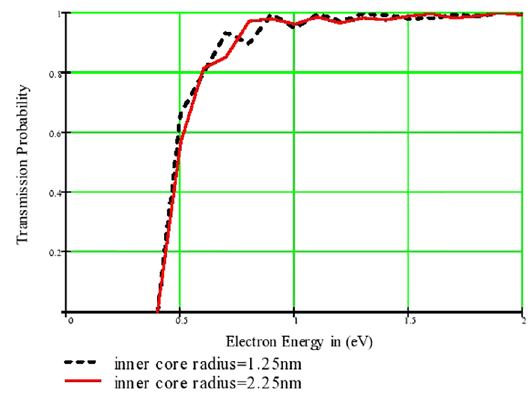
Figure 4. Dependence of electrons transmission probability on energy